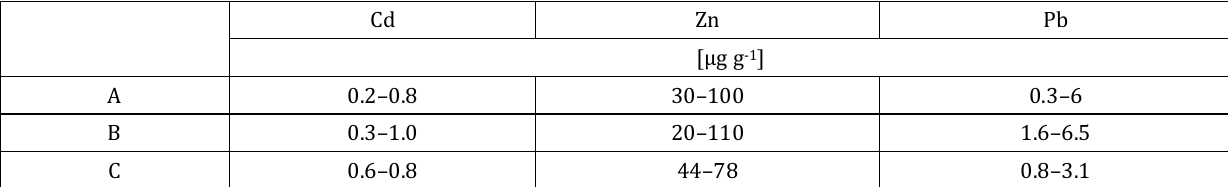
Table 4. Range of heavy metal concentrations in the leaves of T. officinale proposed by different authors as background values (Djingova i in., 2004; Królak,